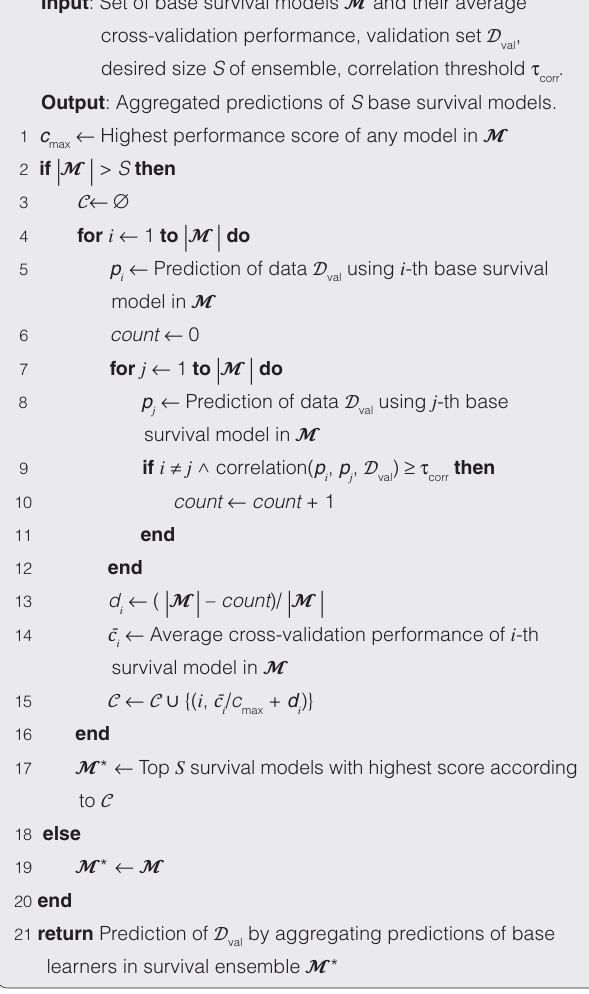
Algorithm 2. Ensemble pruning algorithm of Rooney et al.